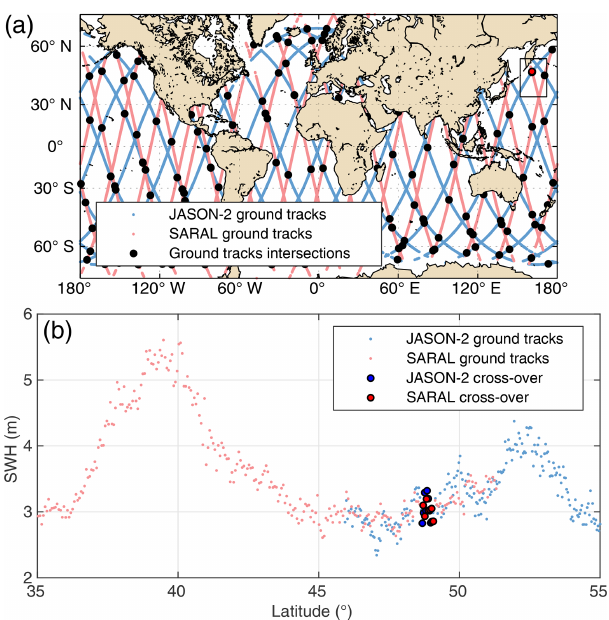
Figure 3. (a) JASON-2 (light blue) and SARAL (light red) ground tracks on 31 March 2018 with the ground track intersection shown with black circles. (b) The along-track data and cross-over are high- lighted in (a)